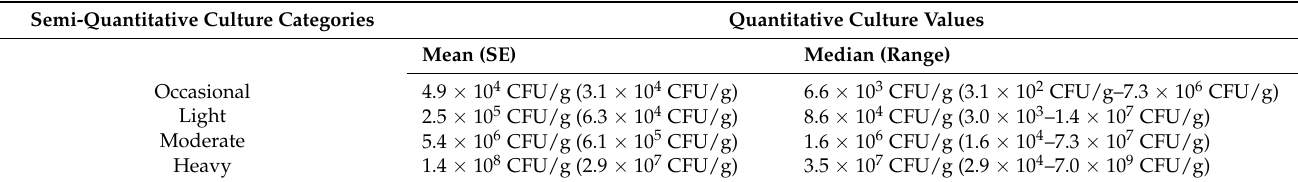
Table 1. Mean (standard error) and median (minimum, maximum) quantitative culture values corresponding to occasional, light, moderate, or heavy categories of semi-quantitative culture. Values reflect all data points ( n = 1053; no outlier rejection). Semi-Quantitative Culture Categories